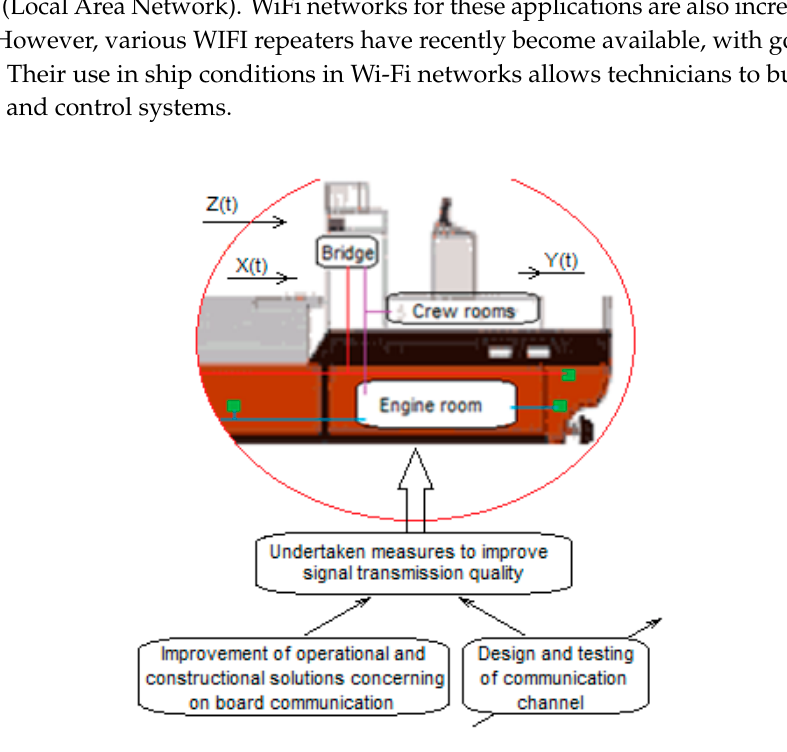
Figure 2. A block diagram of the performed investigation based on the case study-based ZigBee and WiFi networks implementation, where: X(t) – transmitted on board communication signals, Yo(t),– received on board communication signal, Z(t) – disturbances affecting the transmitted signals.